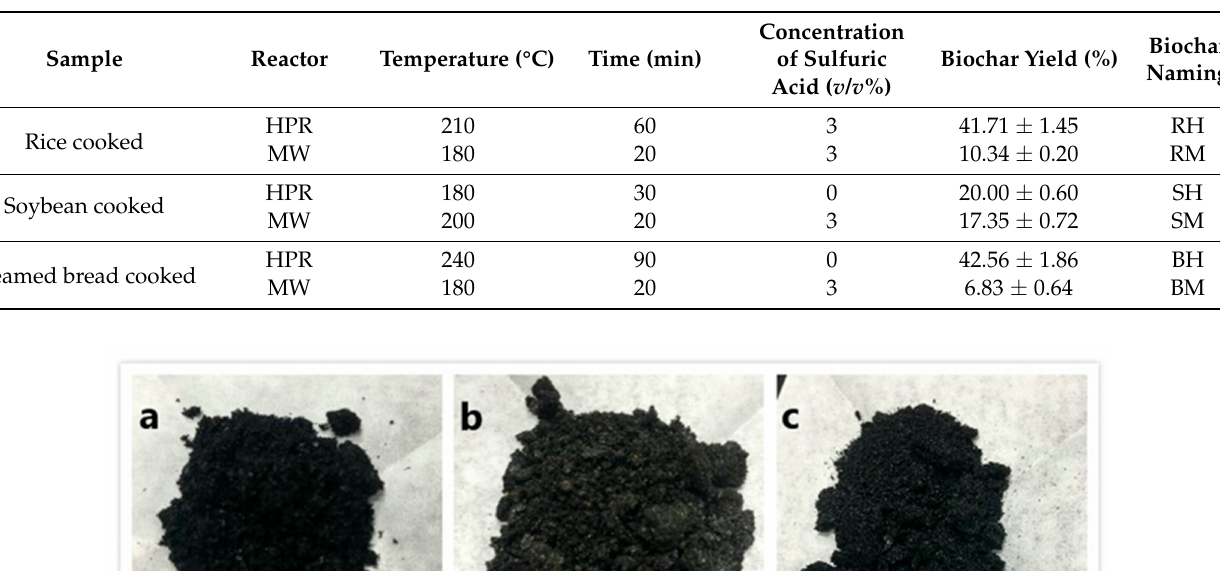
Table 3. The experimental conditions for the preparation of biochar from FW through HTC treatment.